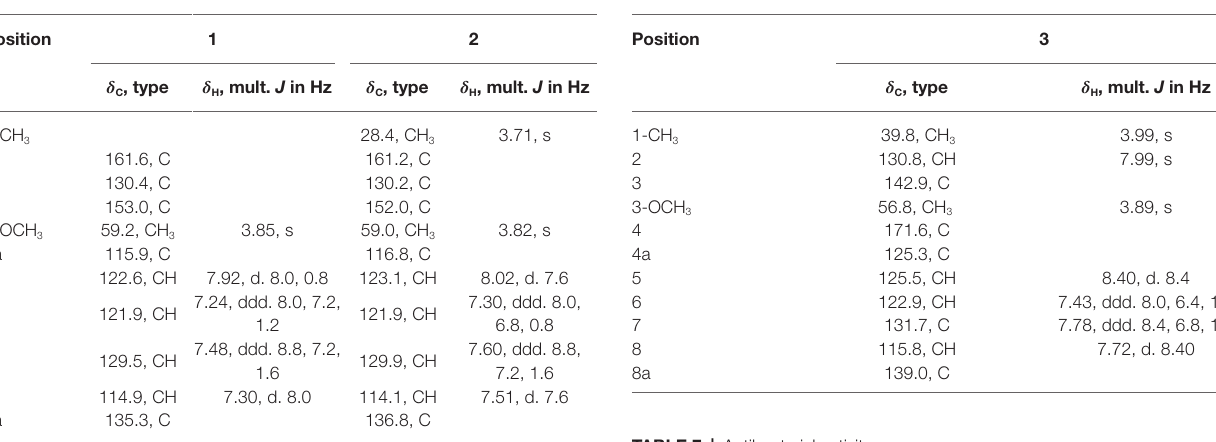
TABLE 5 | 1 H (400 MHz) and 13 C (100 MHz) NMR spectroscopic data for 1 and 2 (methanol- d